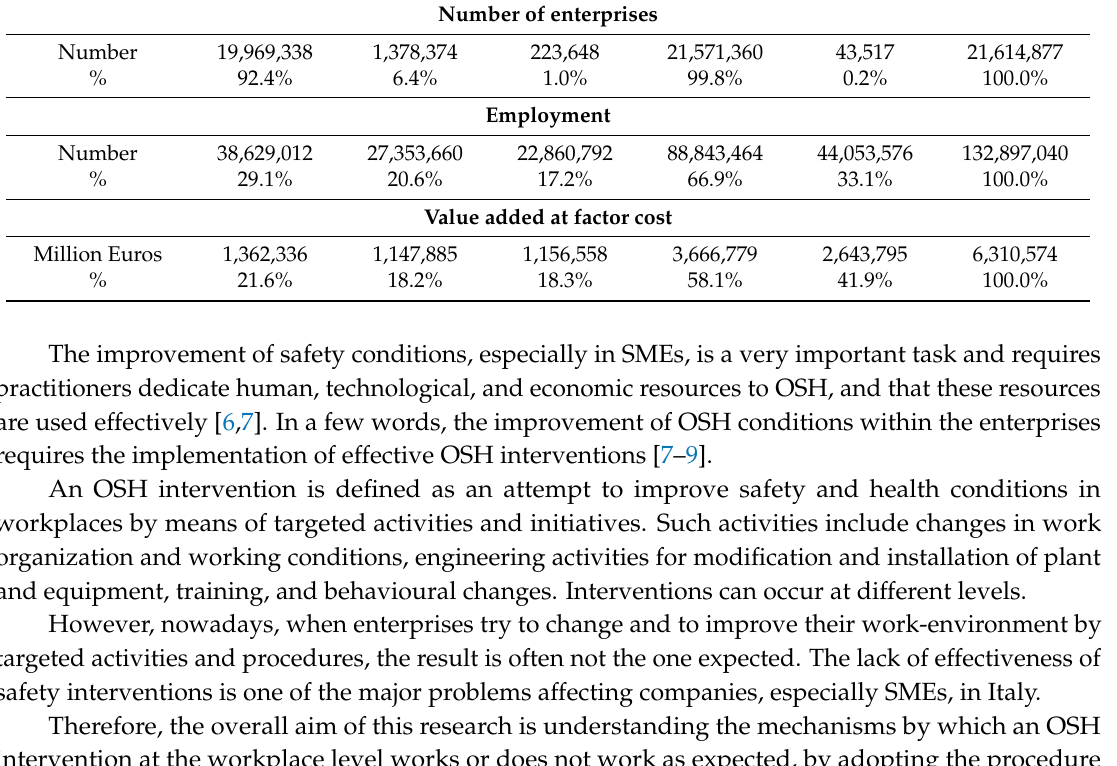
Table 1. SMEs (small and medium-sized enterprises) and large enterprises: number of enterprises, employment and value added in EU-28 in 2013 (elaborated from Eurostat, National Statistical Offices). Micro Small Medium